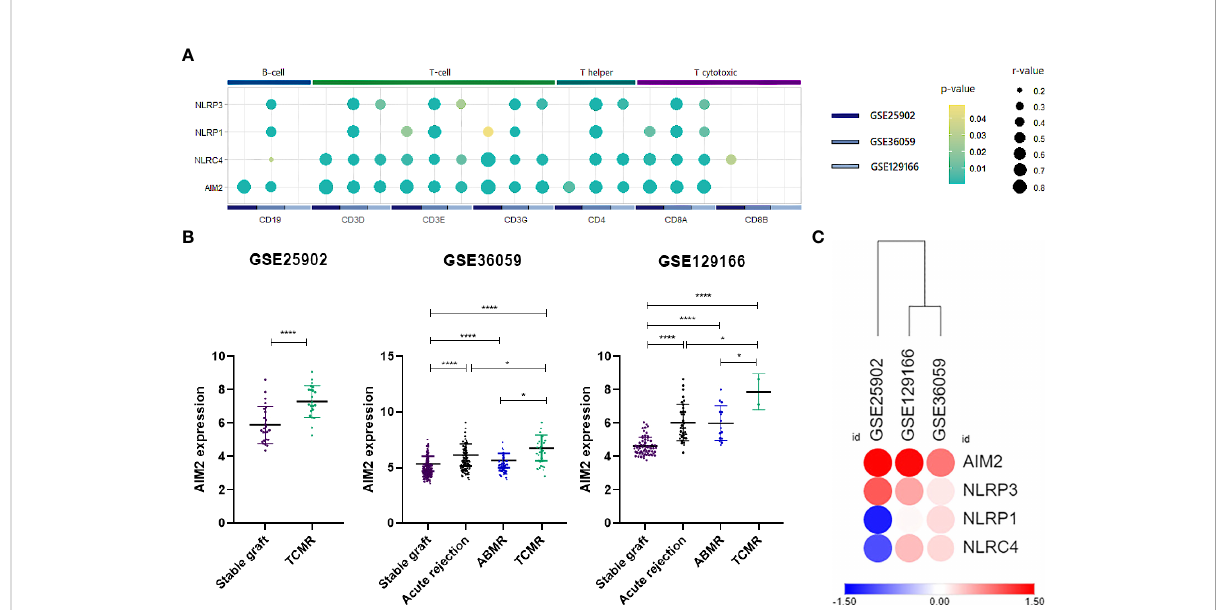
FIGURE 3 AIM2 and in fl ammasomes expression. (A) Log 2 fold-change heatmap for in fl ammasomes comparing acute rejection samples to stable grafts. (B) Scatter plot of AIM2 distribution for three selected datasets (GSE25902, GSE36059, and GSE129166), considering overall acute rejection and its subdivisions TCMR and ABMR. (C) Summarized dot plot representing in fl ammasome correlations between lymphocyte surface markers. Size is designed proportionally to r-value. Yellow color is attributed to less signi fi cant correlations, and green tones are attributed to more signi fi cant ones. Correlations that did not reach a p-value <0.05 were omitted from the scheme. TCMR, T cell-mediated rejection; ABMR, antibody- mediated